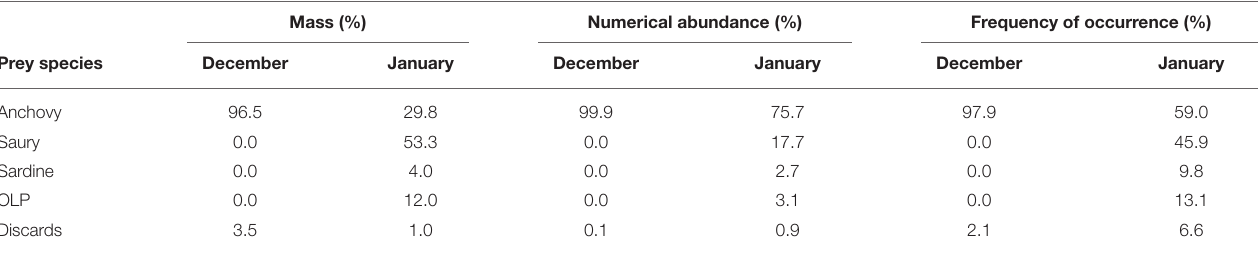
TABLE 6 | The proportional contribution by mass (%), numerical abundance (%), and frequency of occurrence (%) of each of the five prey groups to the diet of Cape gannets during December and January of the 2015/16 breeding season. Mass (%) Numerical abundance (%) Frequency of occurrence (%) Prey